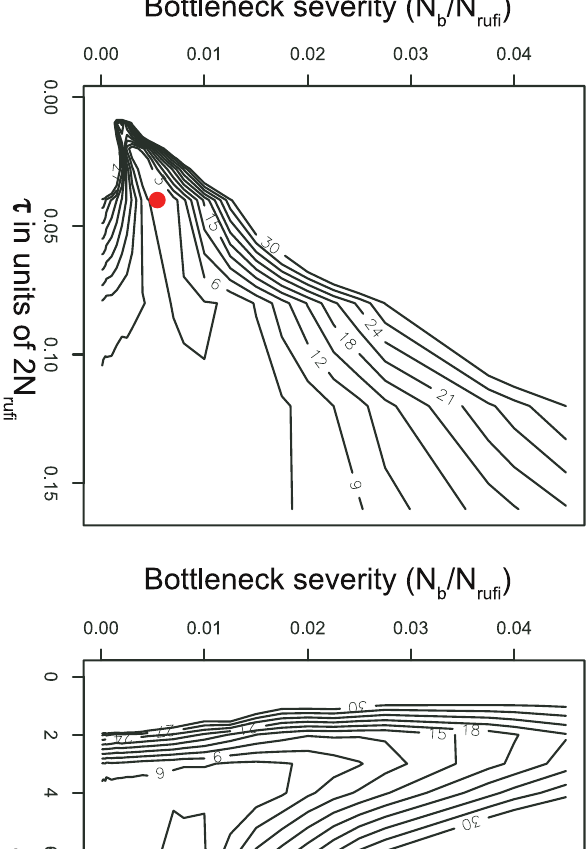
Figure 3. Contours of Composite Profile Log-Likelihood Surface under the Bottleneck and Migration (i.e., ‘‘ Complex Demography ’’ ) Model for Three Key Demographic